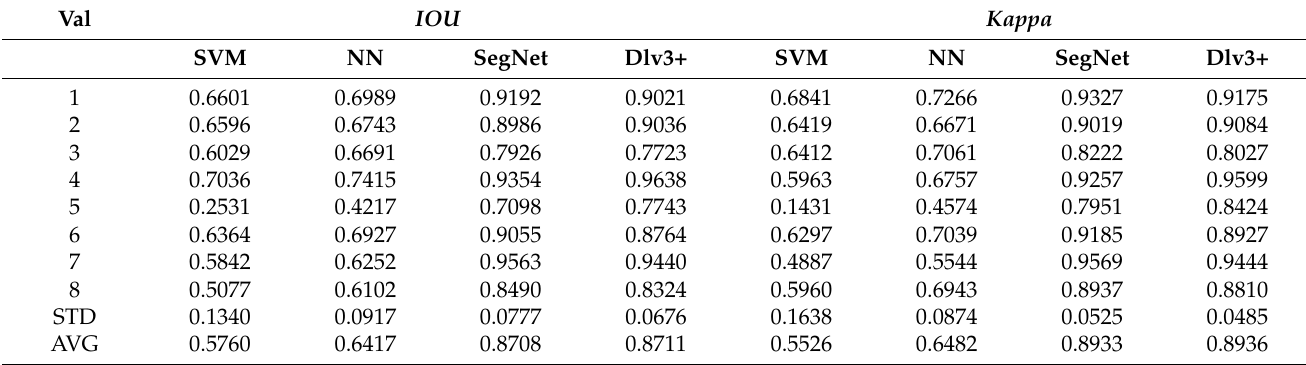
Table 5. Comparison of SVM, NN, SegNet, and Dlv3+ on pixel-wise classification.